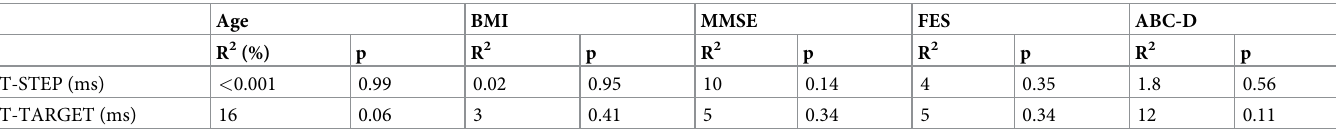
Table 5. Correlations between sequence-specific learning effects and individual characteristics of the older adults in Experiment 2. Age BMI T-STEP